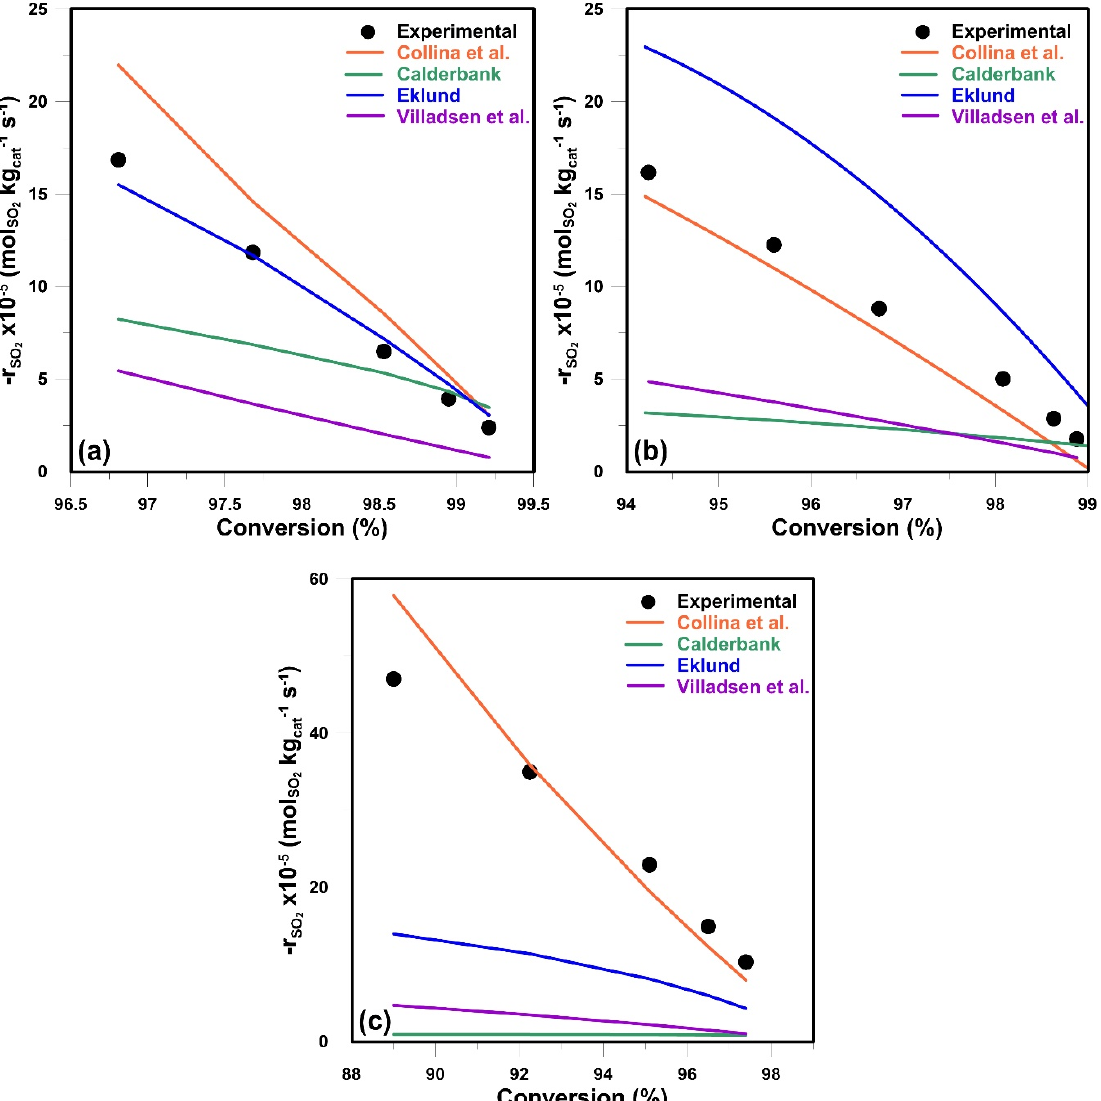
Figure 3. Comparison of the experimental and predicted reaction rates as a function of conversion at T = 400 °C: ( a ) 11 mol% SO 2 , 10 mol% O 2 , and P = 10 atm; ( b ) 11 mol% SO 2 , 10 mol% O 2 , and P = 2.5 atm; and ( c ) 10 mol% SO 2 , 11 mol% O 2 , and P = 1.12 atm.